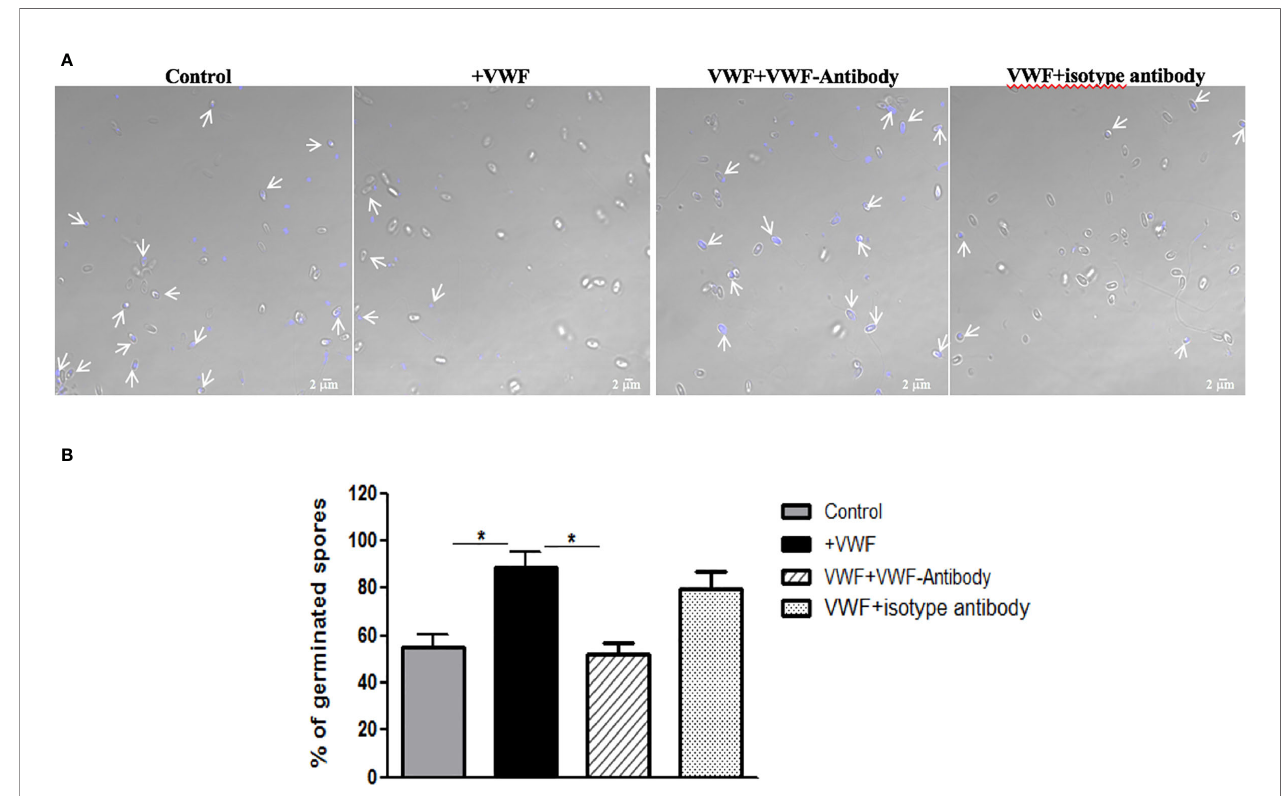
FIGURE 4 | VWF binding promotes E. hellem germination. (A) Representative images of E. hellem germination affected by VWF. The control group E. hellem spores were untreated by any protien; The VWF group E. hellem spores were incubated with FL-VWF; The VWF + VWF-antibody group E. hellem spores were treated by VWF together with anti-VWF antibody; The VWF + isotype antibody group E. hellem spores were treated by VWF together with isotype antibody control. All the spores from each group were then stimulated with germination buffer to further trigger germination. The E. hellem spores were then stained by DAPI, and un- germinated spores will show blue color (pointed out by arrows). (Scale bar = 5 µm). (B) Germination rates were calculated by the ratio of germinated spores over all spores, based on three independent studies with 10 random fi elds per study. The results showed that VWF treatment signi fi cantly promoted E. hellem spores ’ germination (F(1,29) = 1.89, *P <0.05), and this effect was inhibited by VWF speci fi c antibody (F(1, 29) = 2.09, *P